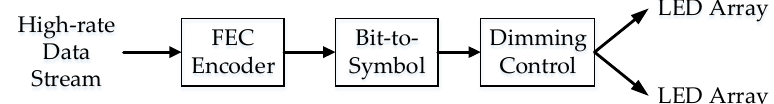
Figure 3. Reference architecture of the dimmable spatial 8-phase shift keying (DS8-PSK) transmitter.